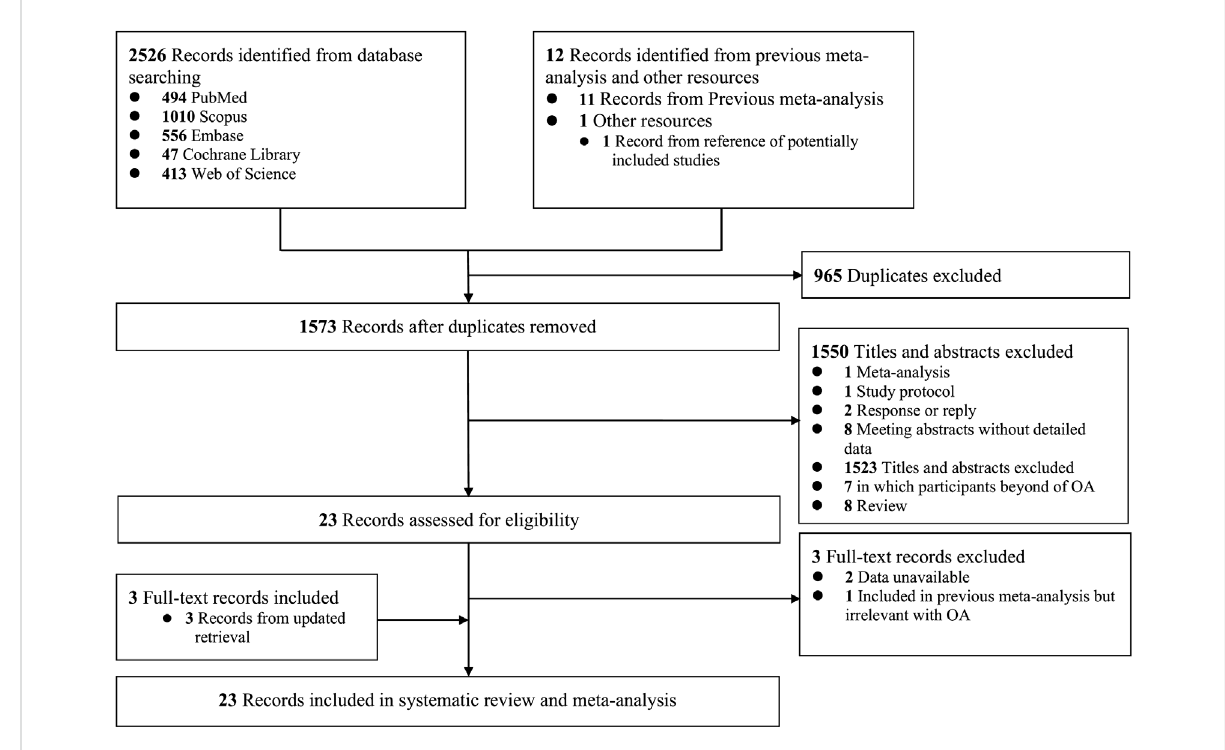
FIGURE 1 Flow diagram of literature